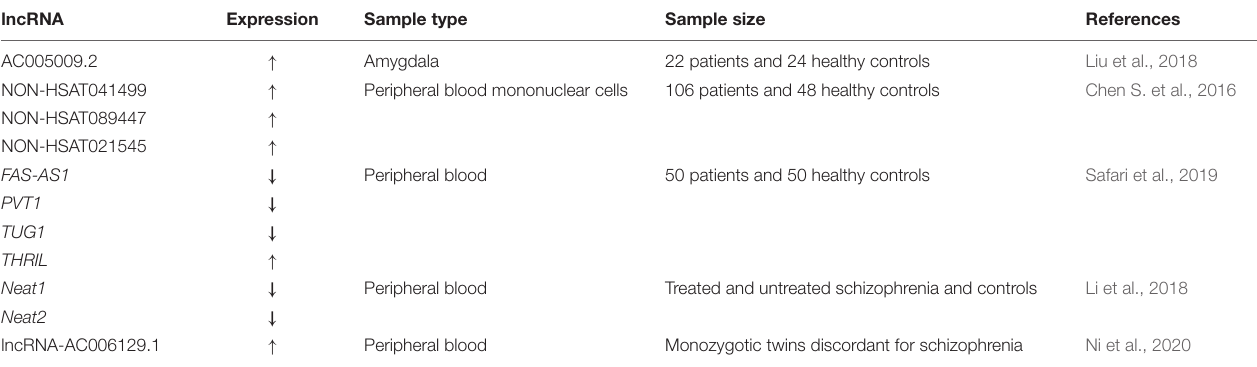
TABLE 2 | Recently reported change of lncRNA expression in patients with